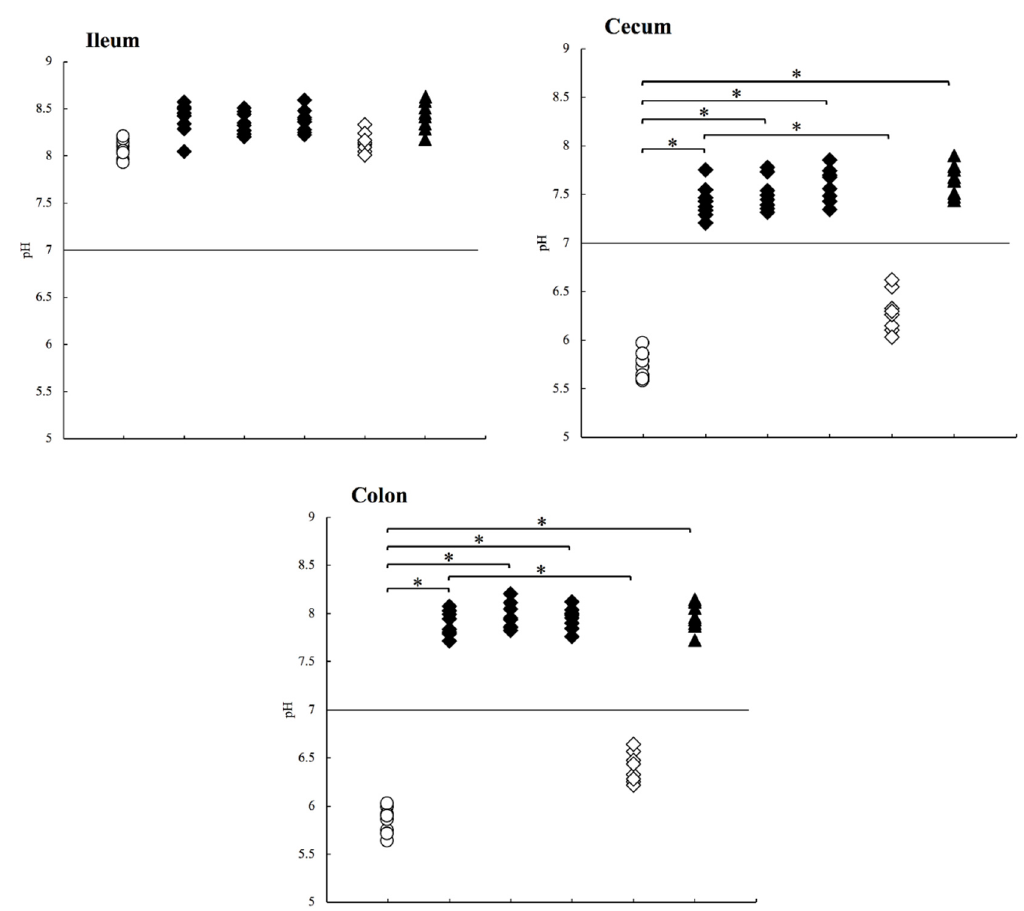
Figure 4. pH values measured in the mice treated with antibiotics studied in the following groups. The antibiotic groups included mice treated with antibiotics (Amp: ampicillin, Cpz: cefoperazone, Van: vancomycin, ◆ black diamond); Amp- DW, mice switched back to distilled water after ampicillin treatment ( ◇ white diamond); GF, germ-free mice ( ▲ black triangle) and control mice ( ○ white circle). * p < 0.01. In the cecum and colon, the differences between Control vs. Amp/Cpz/Van/GF > Amp vs. Amp-DW.